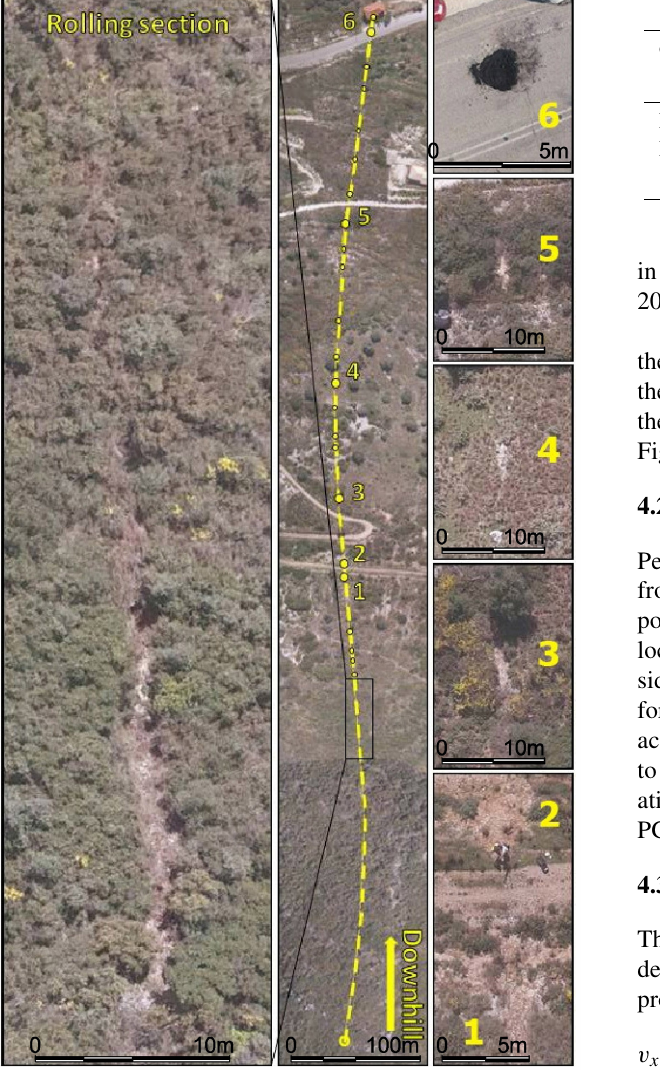
Figure 5. Top view orthophoto denoting rolling section, bouncing positions and indicative closeups of impact points.